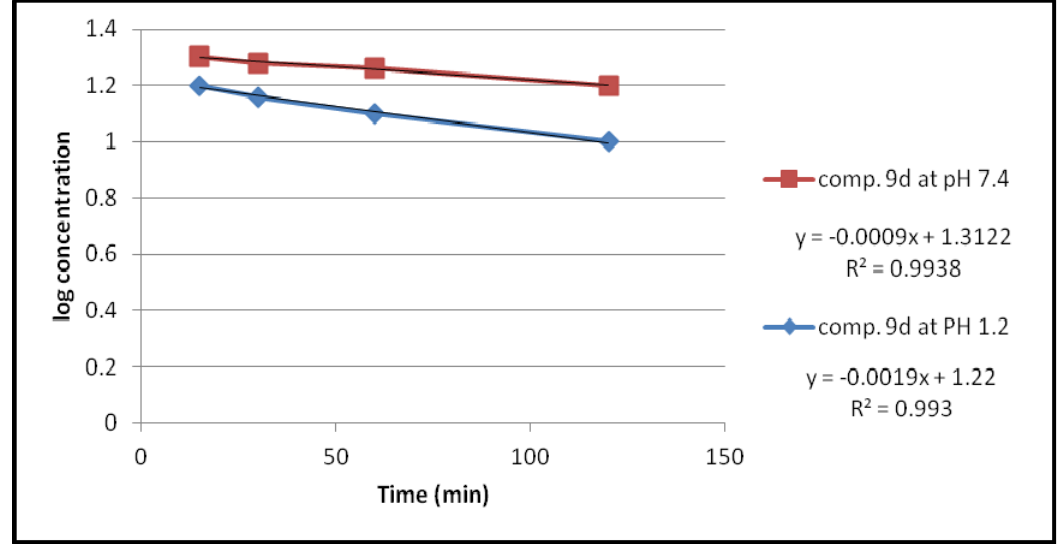
Figure 5. The hydrolysis rate of compound 9d at different pH